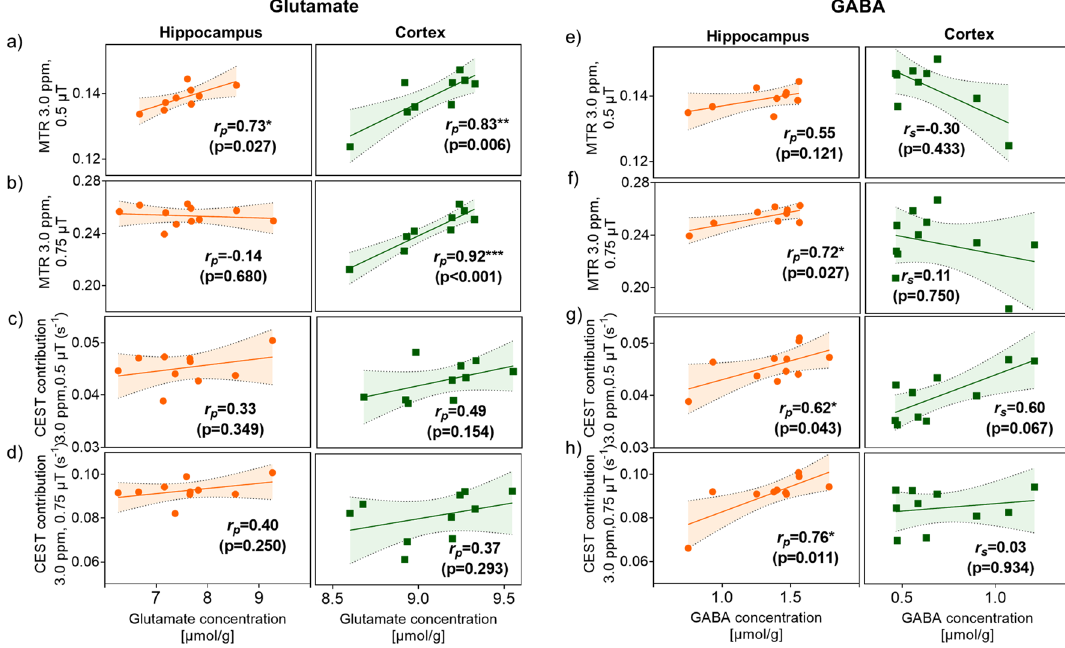
Figure 6. Correlation of ( a – d ) ELISA-derived glutamate and ( e – h ) GABA levels with MTR and CEST contribution measured at 3.0 ppm in the hippocampus (orange circles) and cortex (green squares) of the stressed group of animals. Shaded areas indicate the 95% confidence interval. The analysis was performed either with the parametric (Pearson’s, r p ) or nonparametric (Spearman’s, r s ) test.